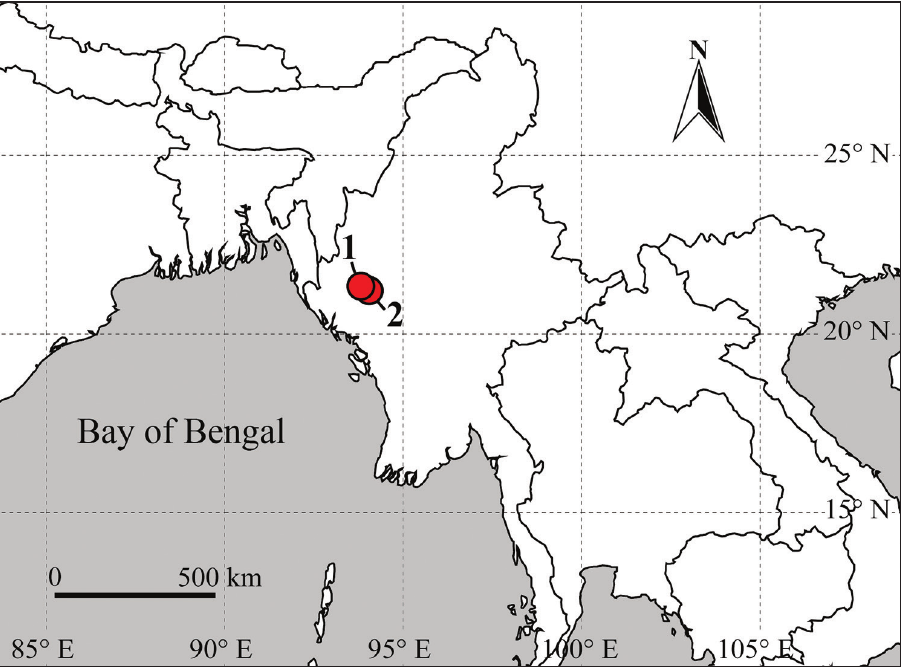
Figure 13. Collection localities of Myanmarorchestia species from Myanmar. 1 Myanmarorchestia peterjae- geri Hou, sp. n. 2 M. seabri Hou, sp.